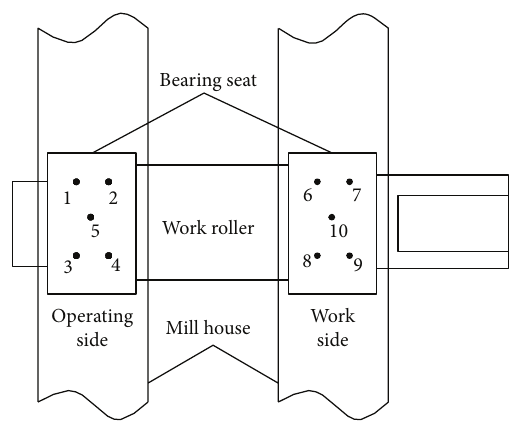
Figure 3: Clearance